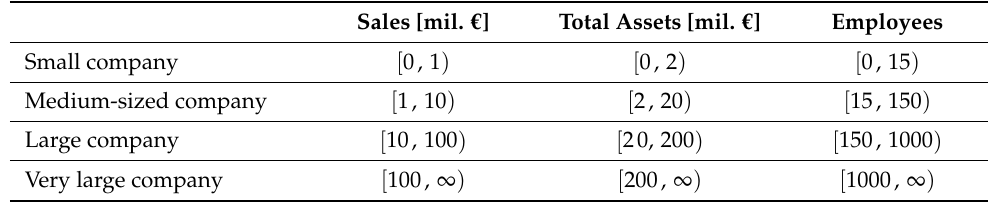
Table 1. The classification of enterprises. Sales [mil. € ] Total Assets [mil. €